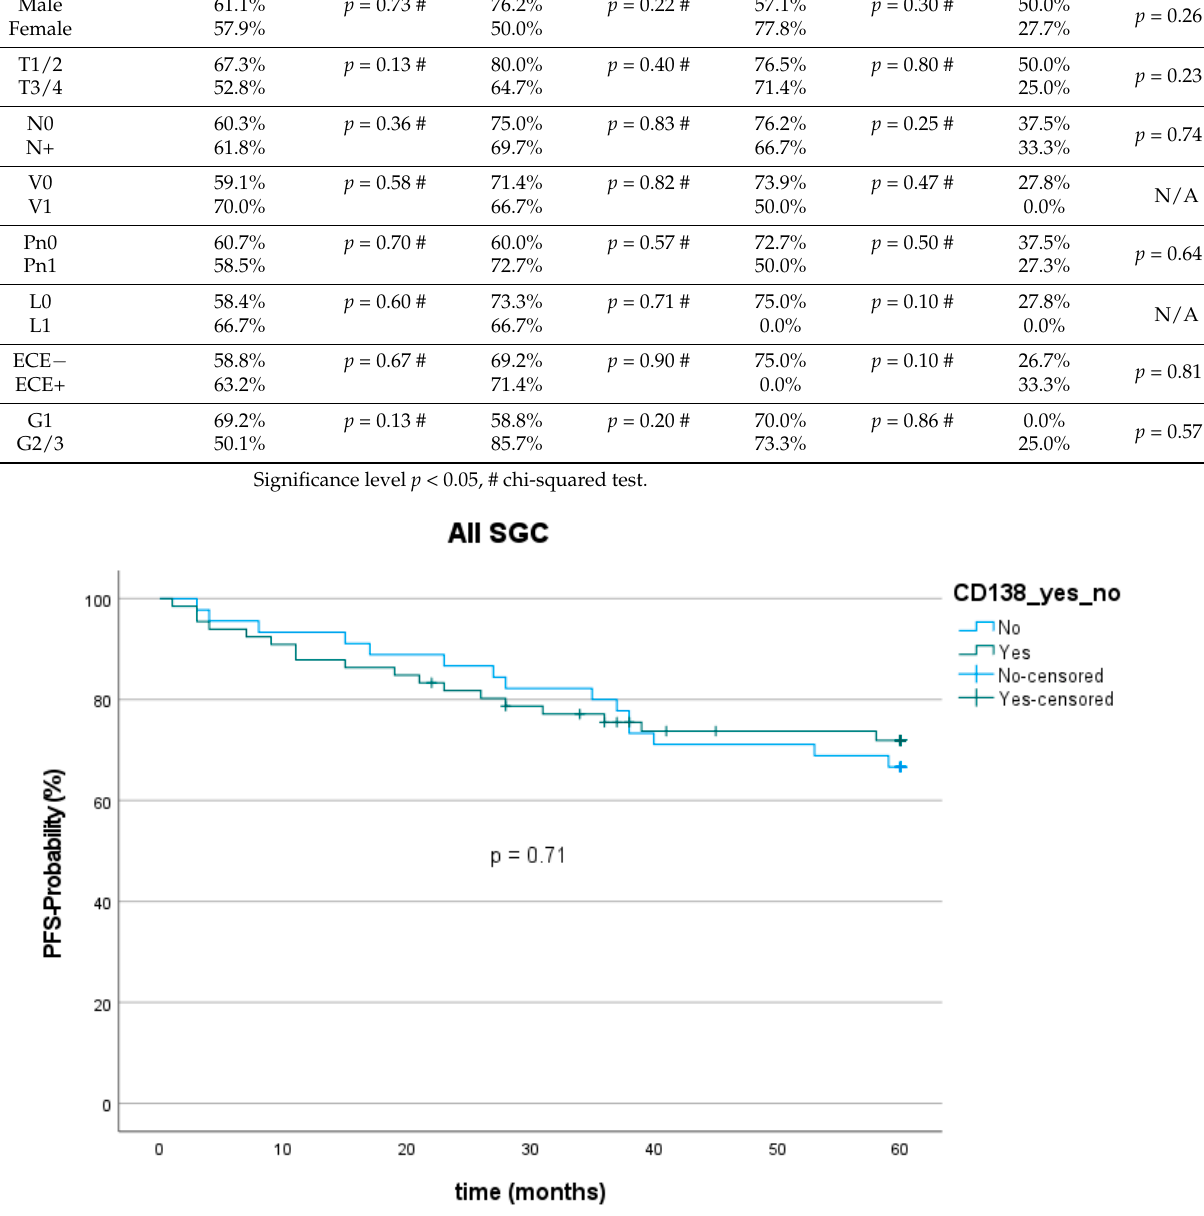
Figure 7. Kaplan–Meier curve and p -value of log-rank test for CD138 expression among all entities of salivary gland cancer (SGC). PFS = Progression-free survival.